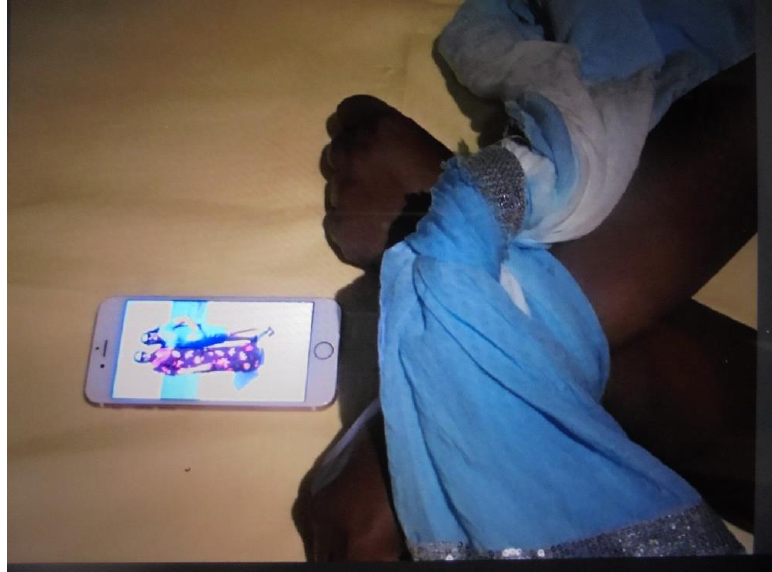
Figure 3. Photograph of a community researcher whose hands are tied while looking at a picture from her mother who lives in Surinam, titled: “ missing out/the loss ” .